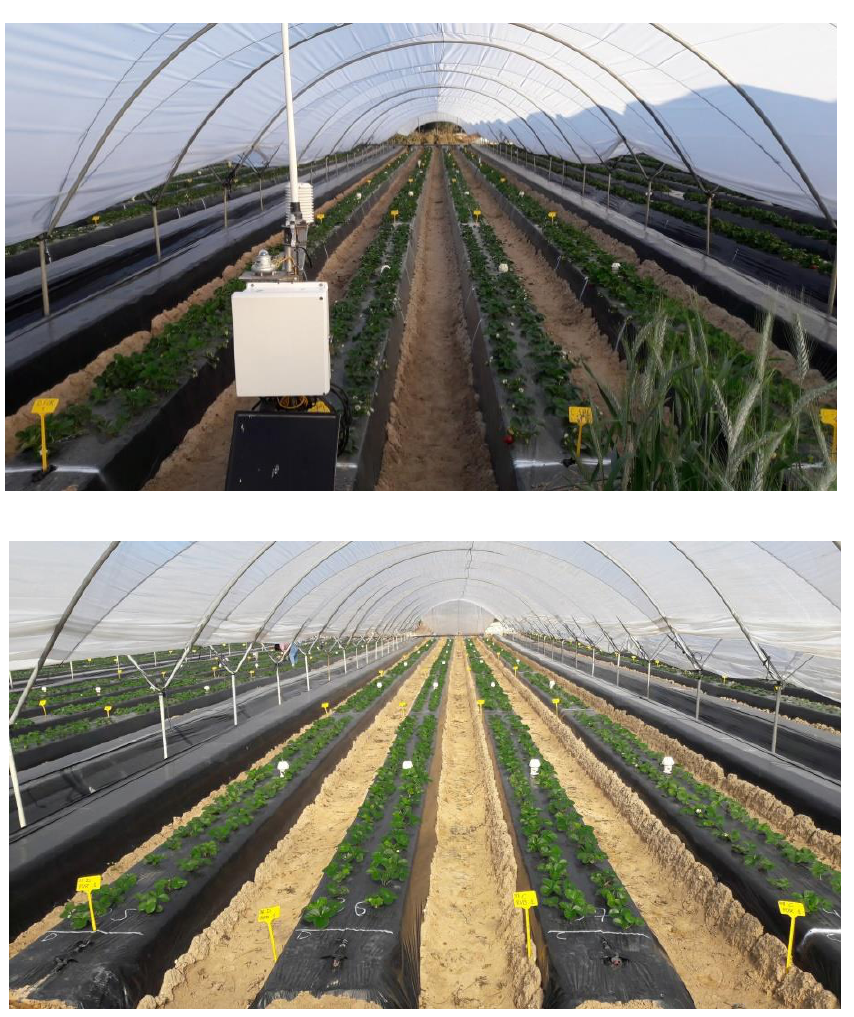
Figure A1. Field experimental setup in the 2016–2017 and 2017–2018 cropping seasons (pictures taken in 22-12-2016 and 20-11-2017, respectively).